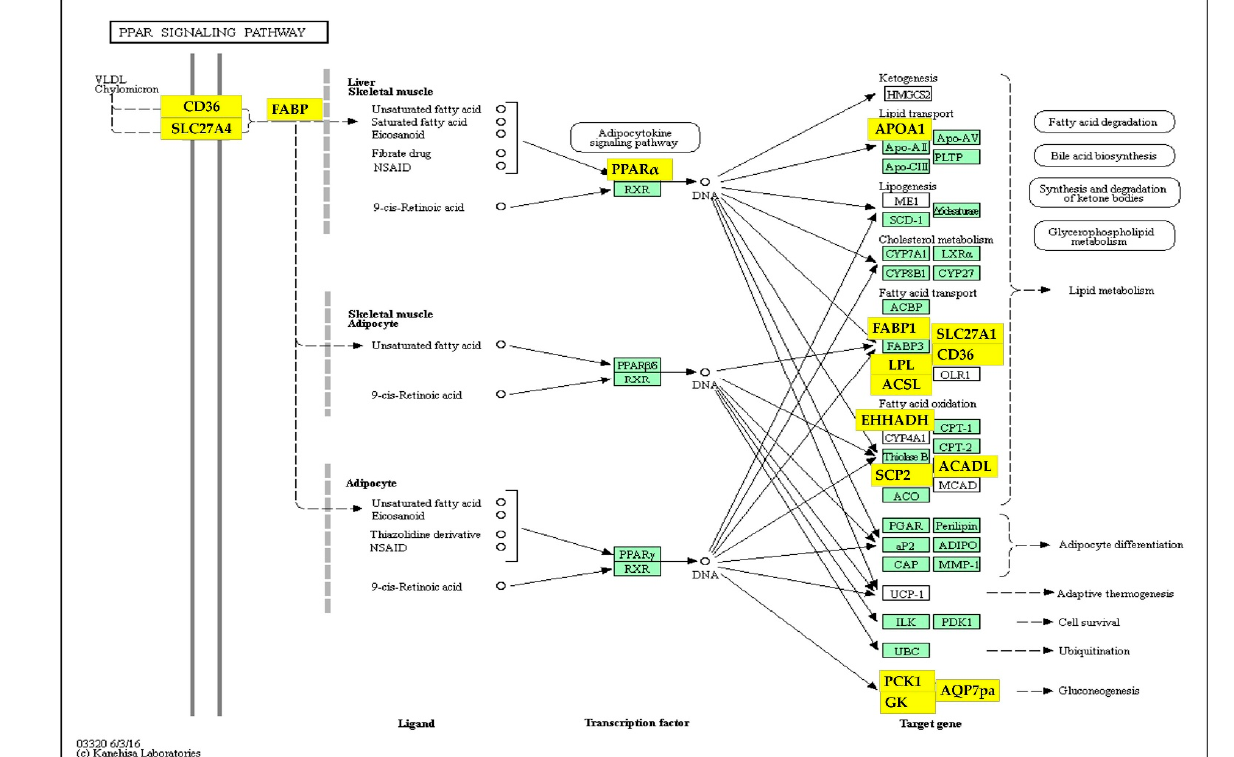
Figure 2. PPAR (peroxisome proliferator-activated receptor) signaling pathway enriched of differentially expressed genes (DEGs) in the jejunum of broiler chickens. The PPAR signaling pathway as the DAVID (Database for Annotation, Visualization and Integrated Discovery) functional annotation significantly enriched DEG is visualized by the Kyoto Encyclopedia of Genes and Genomes (KEGG) [10] pathway mapper. Genes over-expressed in the jejunum are shown in a yellow color. CD36: CD36 molecule; ACADL : acyl-CoA dehydrogenase long chain; ACSL : acyl-CoA synthetase long-chain family member ( ACSL3, ACSL4, ACSL5 ); APOA1 : apolipoprotein A-1; AQP7 : aquaporin 7; EHHADH: bi-enzyme enoyl-CoA hydratase/3-hydroxy acyl CoA dehydrogenase; FABP : fatty-acid binding protein ( FABP1, FABP2, FABP5, FABP6 ); GK: glycerol kinase; LPL : lipoprotein lipase; PPAR α : peroxisome proliferator-activated receptor alpha; PCK1 : phosphoenolpyruvate carboxykinase 1; SCL27A1/4: solute carrier family 27 (fatty-acid transporter), member 1, member 4 ; SCP2 : solute carrier protein 2.